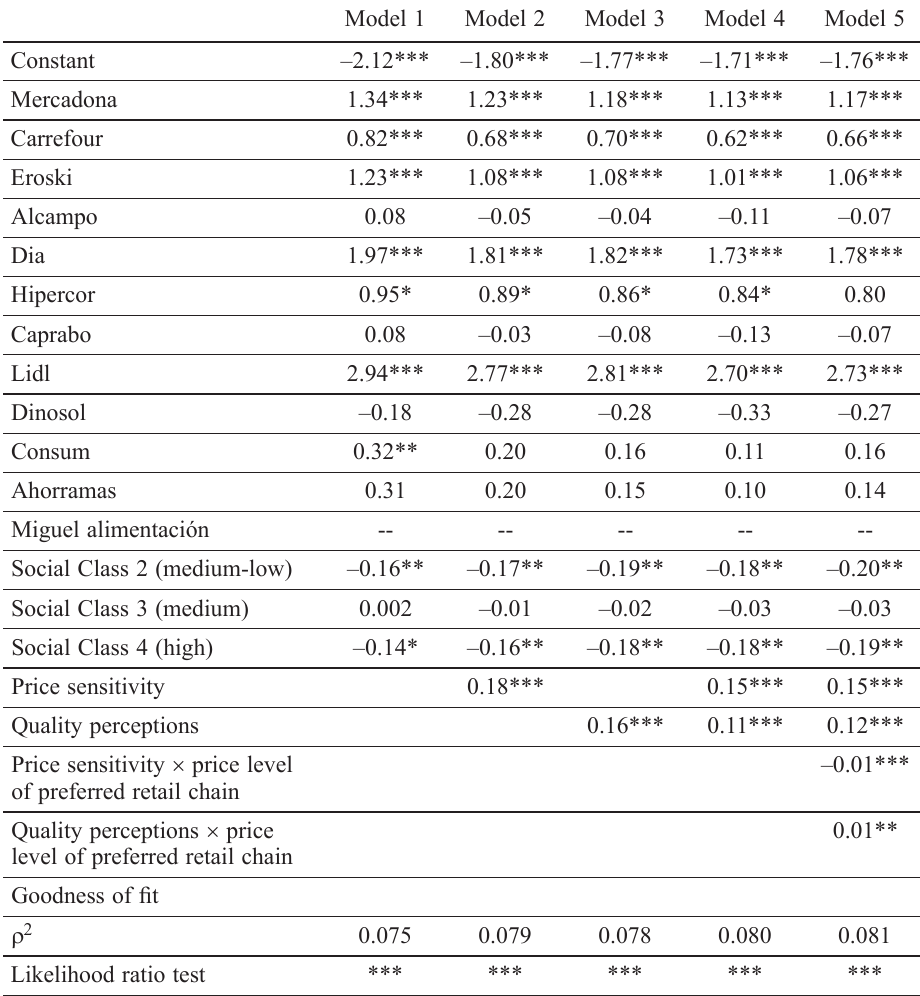
Table 3. Estimation